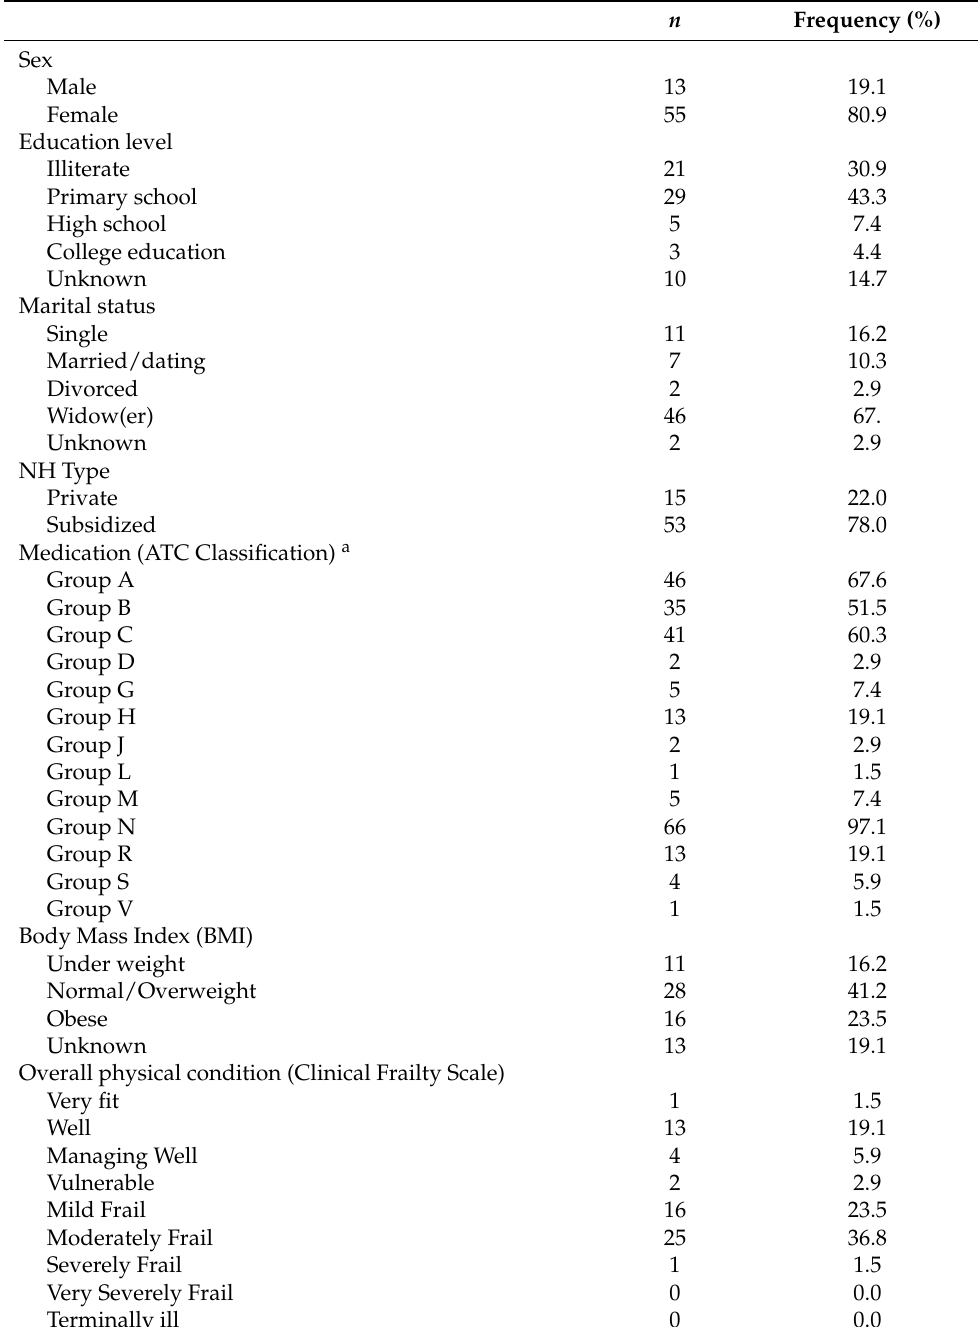
Table 1. Socio-demographic and health-related information of five nursing homes ( n = 68) from Osona, Spain